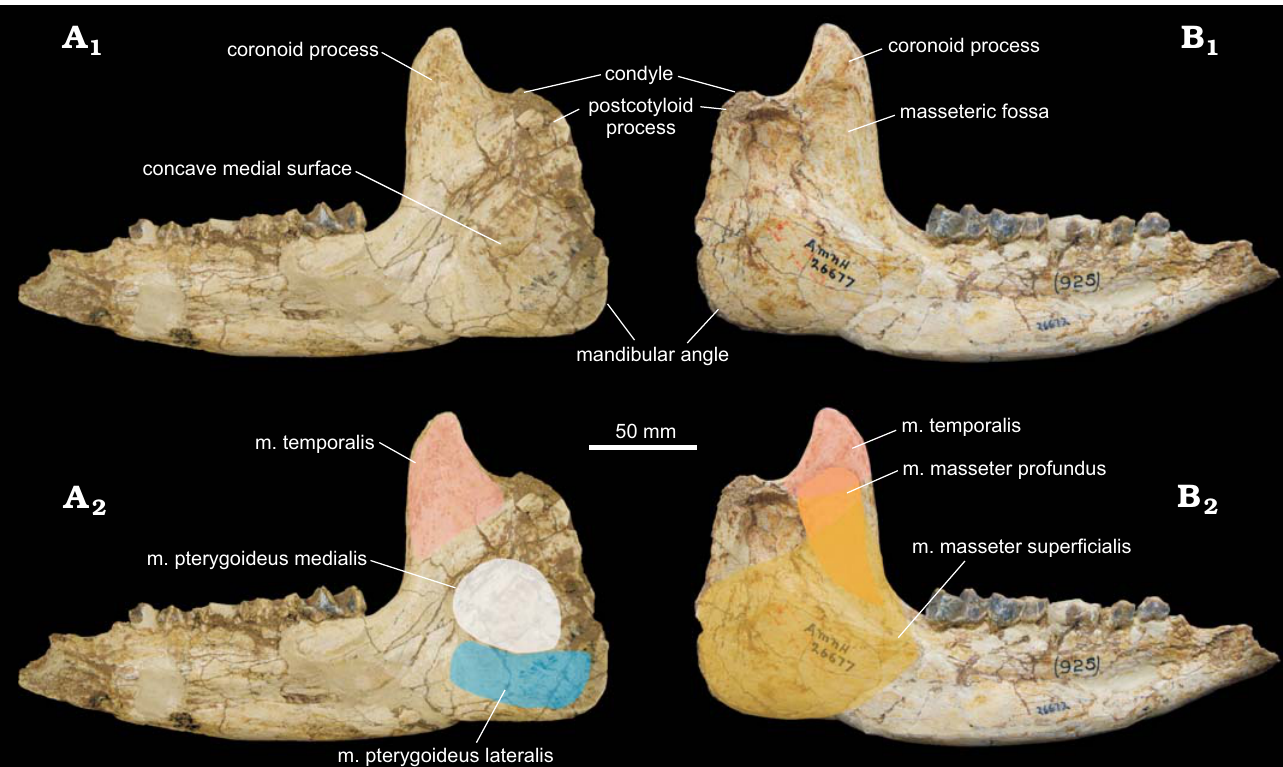
Fig. 3. Mandible of the paraceratheriid rhinocerotoid Pappaceras meiomenus H.B. Wang, Bai, Meng, and Y.Q. Wang, 2016 (AMNH 26677) from the late Early Eocene Arshanto Formation, Erlian Basin, Nei Mongol, China, in medial ( A ) and lateral ( B ) views. A 1 , B 1 , photographs, A 2 , B 2 , interpretations of muscular